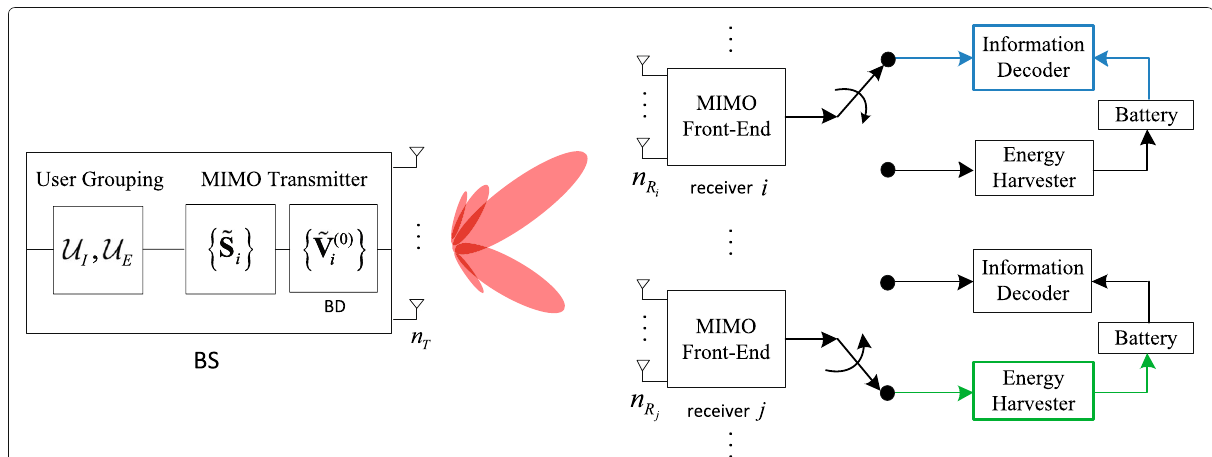
Fig. 1 Broadcast multiuser system. Schematic representation of the downlink broadcast multiuser communication system. Note that each user can switch from an information decoder receiver to an energy harvester receiver. This switching can be implemented technologically, as mentioned in papers such as